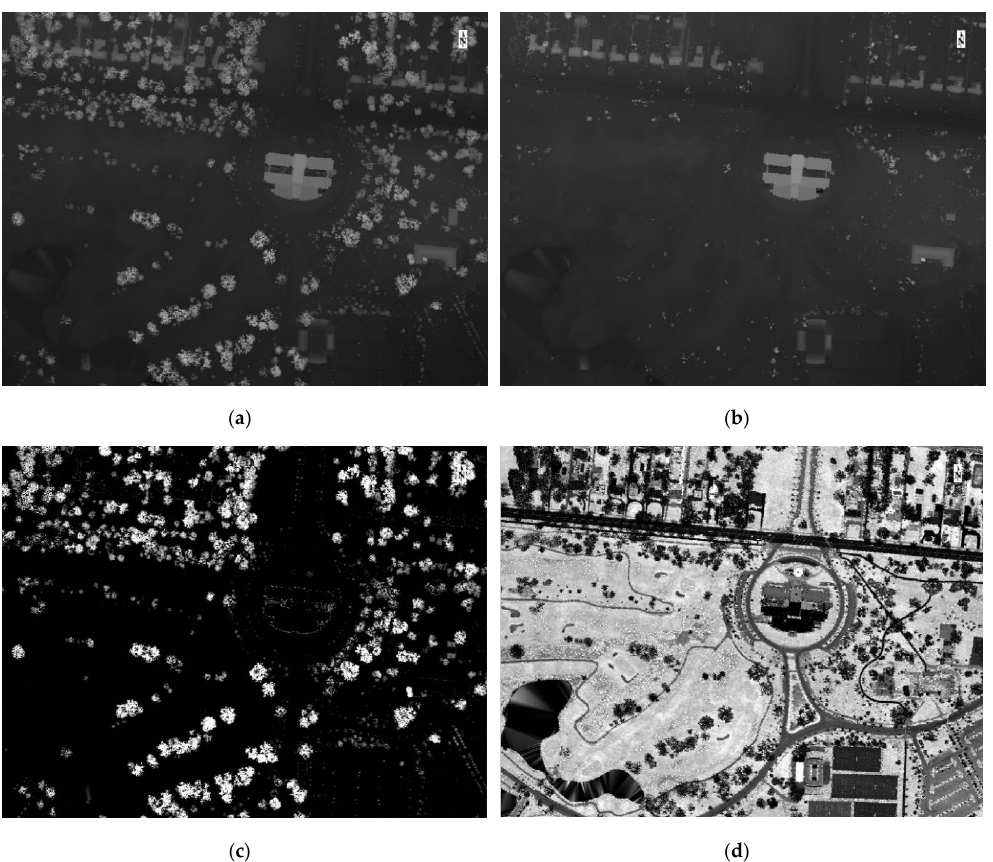
Figure 4. LiDAR data processing steps. ( a ) First return LAS data. ( b ) Last return LAS data. ( c ) Relative height model (last return subtracted from first return). ( d ) LiDAR intensity return